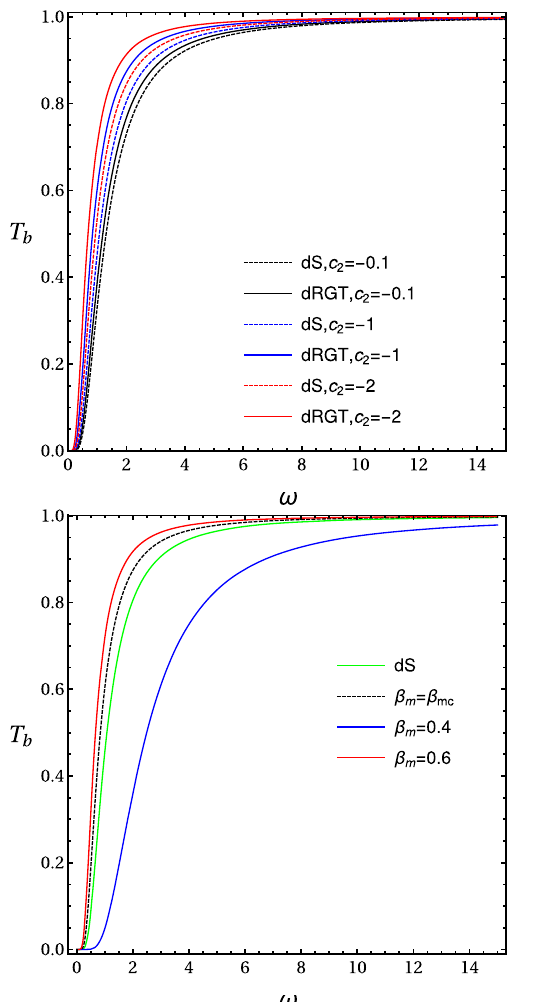
Fig. 7 The left panel shows a comparison of the rigorous bound of greybody factor for the dRGT and the de Sitter black holes with (cid:18) = 0, ˜ M = α g = 0 . 1, while the parameter β m is chosen to have the same height of potential. The right panel shows the rigorous bound for c 2 = − 1